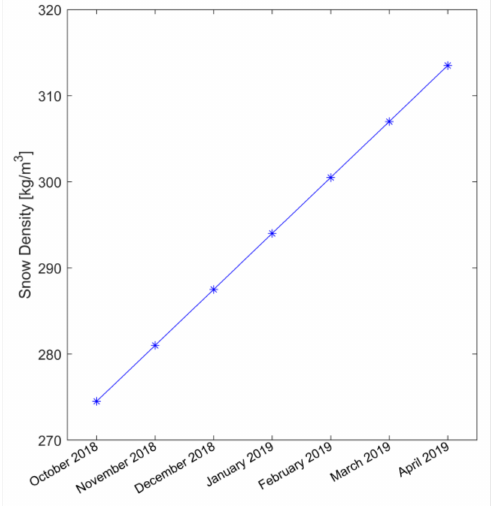
Figure 2. Time series of snow